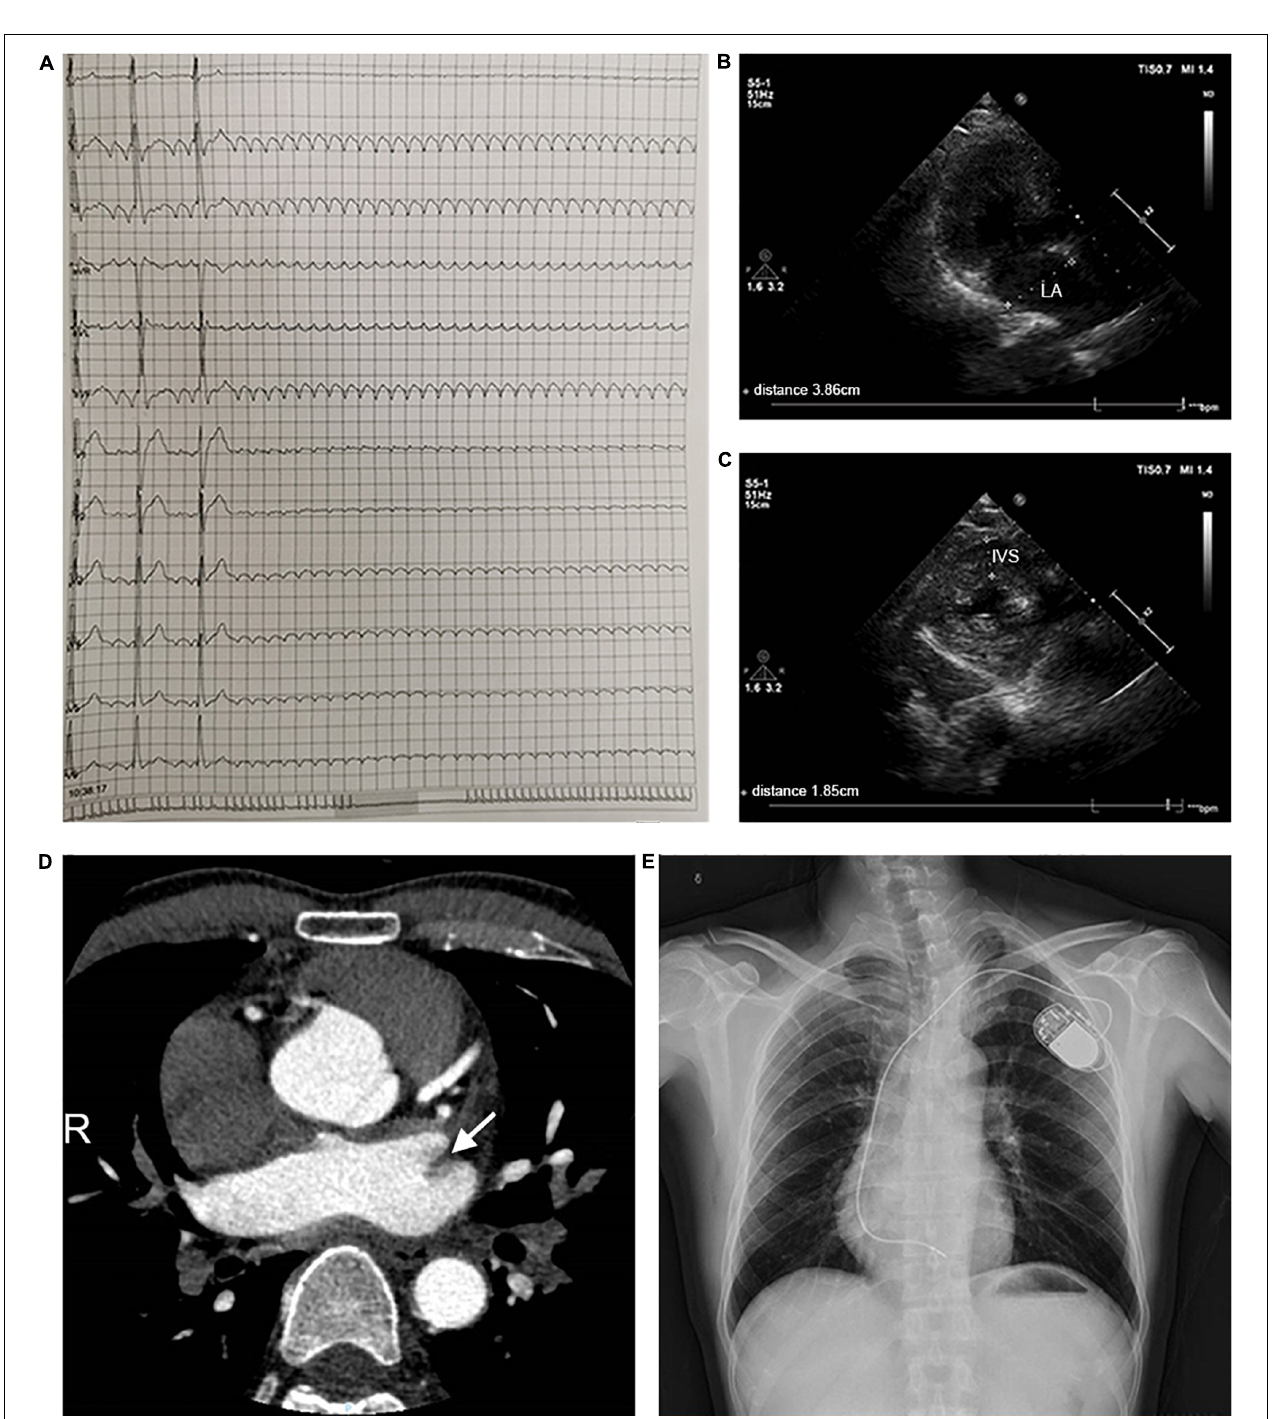
FIGURE 1 | Clinical parameters for the pedigree. (A) 24-h Holter monitoring of the proband. (B,C) Echocardiographic parameters, including LAD and IVS. (D) The cardiac CT-scan indicated atrial thrombus (shown by the arrow). (E) A posteroanterior chest X-ray was taken immediately after pacemaker implantation. Abbreviations: LA, left atrium; IVS, interventricular